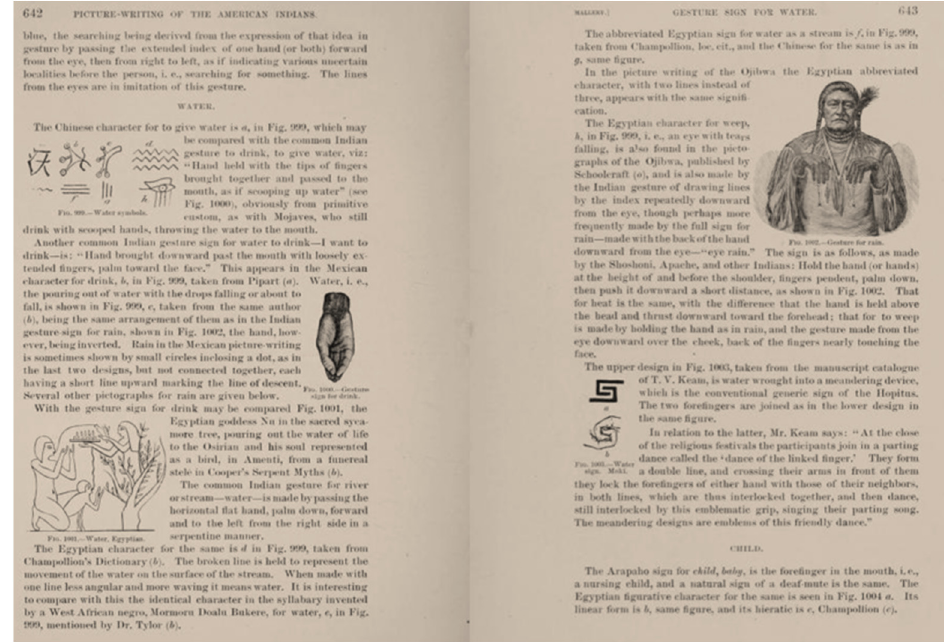
Figure 21. Garrick Mallery (1893). Tenth Annual Report to the Bureau of Ethnology.